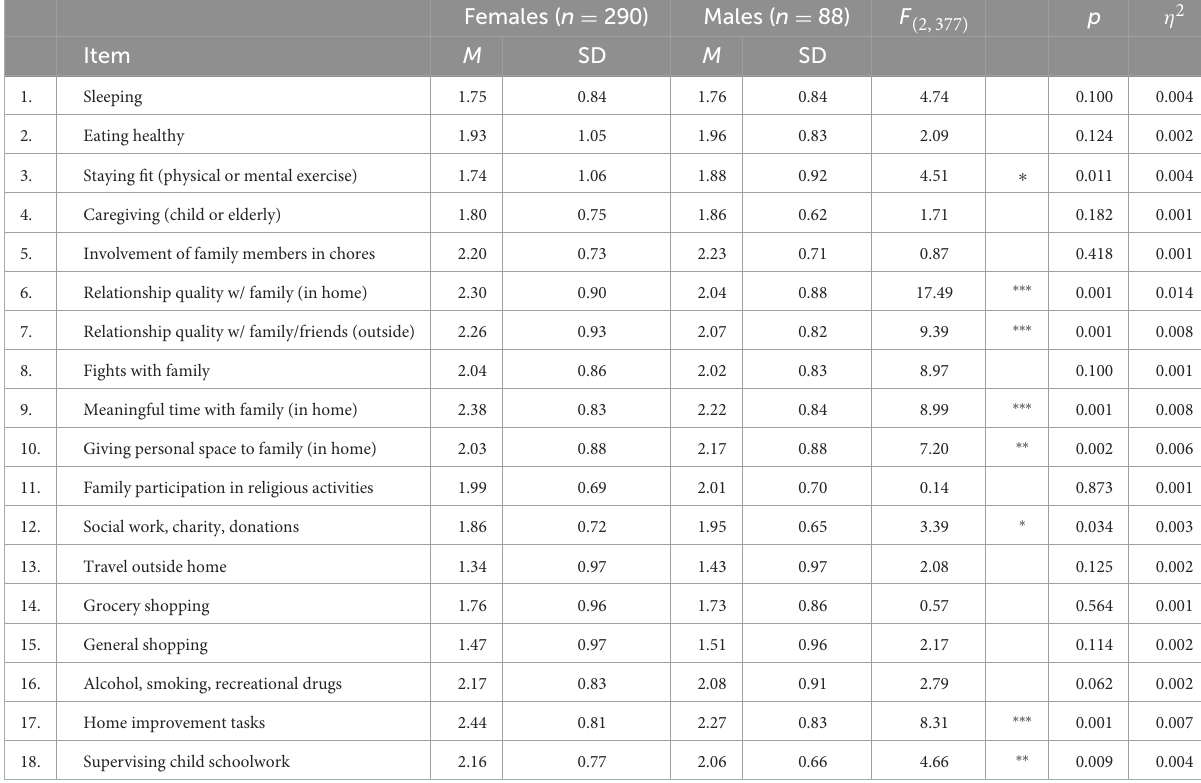
TABLE 2 Gender differences in perceived quality of family routines before and during